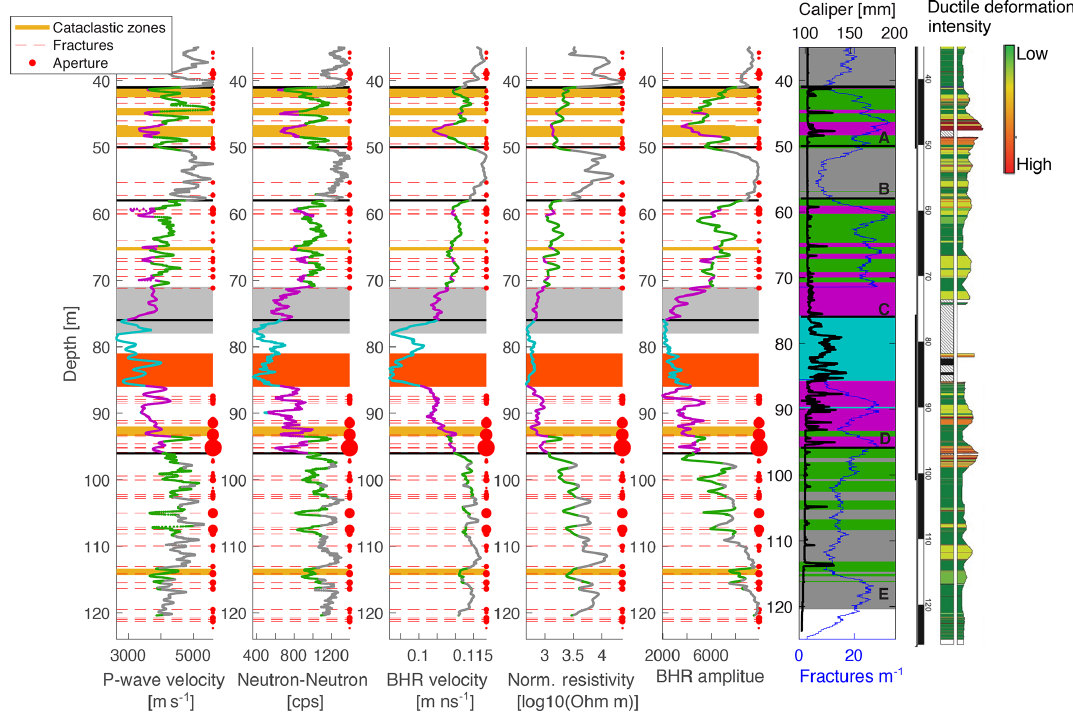
Figure 8. Borehole log data used for cluster analysis, color-coded according to the four cluster groups identified in Fig. 7 and overlain by brittle deformation inferred from the OTV data. The righthand column shows the sequence of clusters along the borehole together with the fracture density inferred from the OTV data, the ductile deformation intensity log (Egli et al., 2018), the caliper data, and the zonation A through E inferred from the Stoneley wave analysis (Fig.